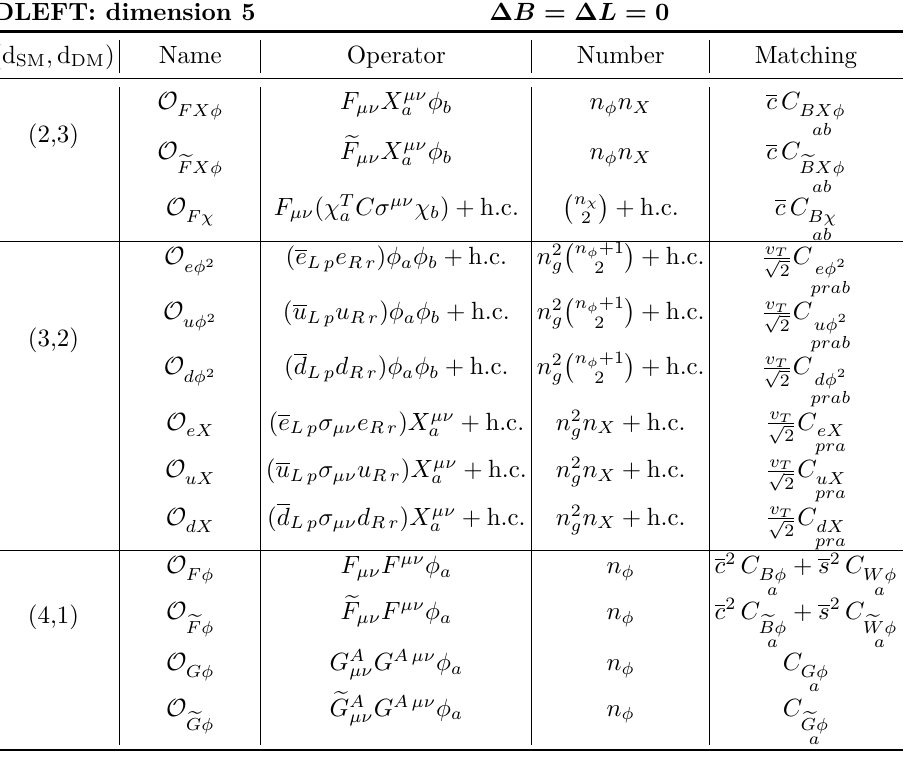
and O are not eX eφ 2